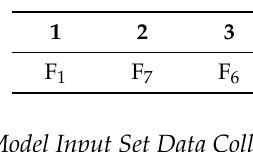
Table 12. Priority ranking of technical features.